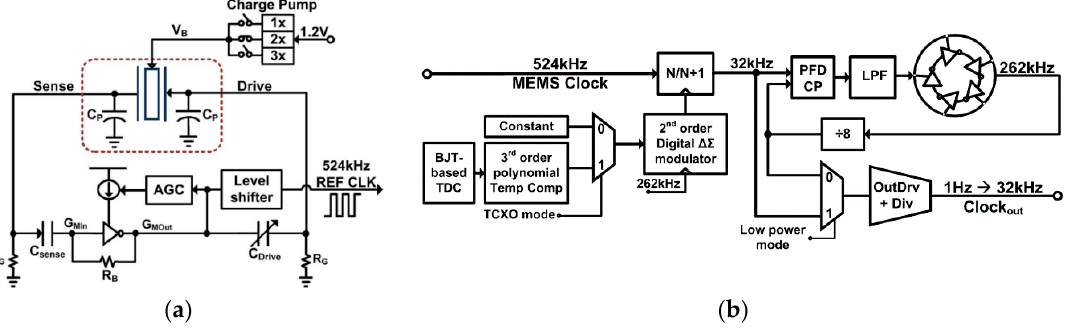
Figure 21. ( a ) A MEMS oscillator and ( b ) its compensation and frequency synthesis electronics